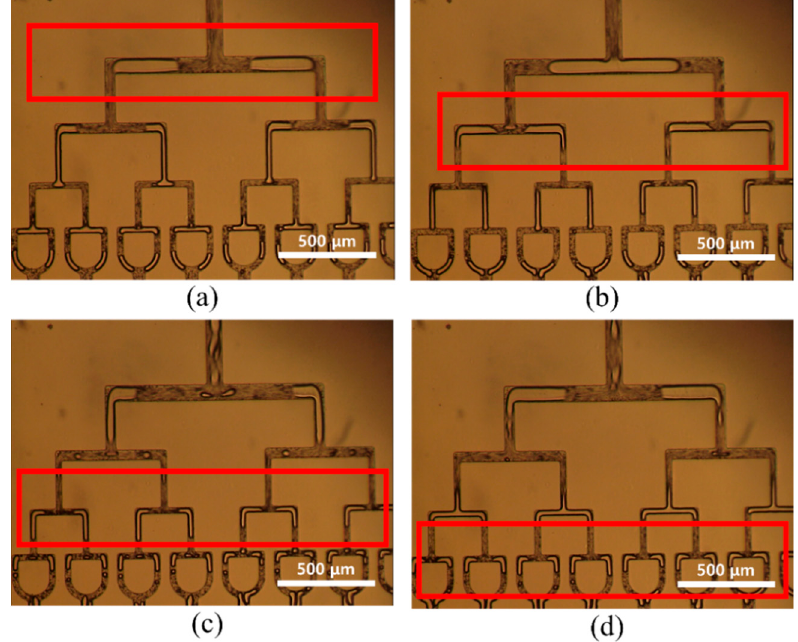
Figure 5. ( a – d ) Optical images of divided water droplets from the sixth T-junction to the ninth T-junction in the 512-channel geometrical passive breakup device.